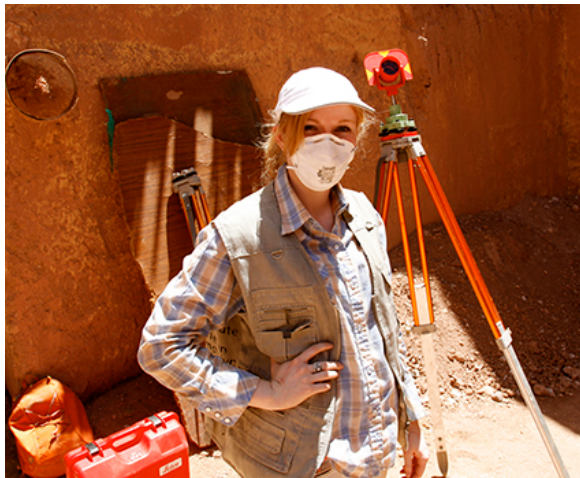
Figure 9: CIMS team member using protective gear during documentation of the Caïd Residence within the Kasbah Taourirt